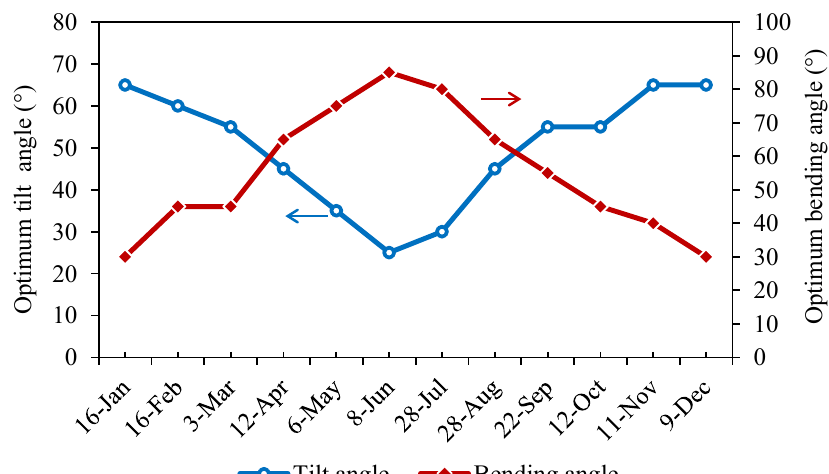
Figure 6. Optimum tilt and bending angles for the east and west wings by